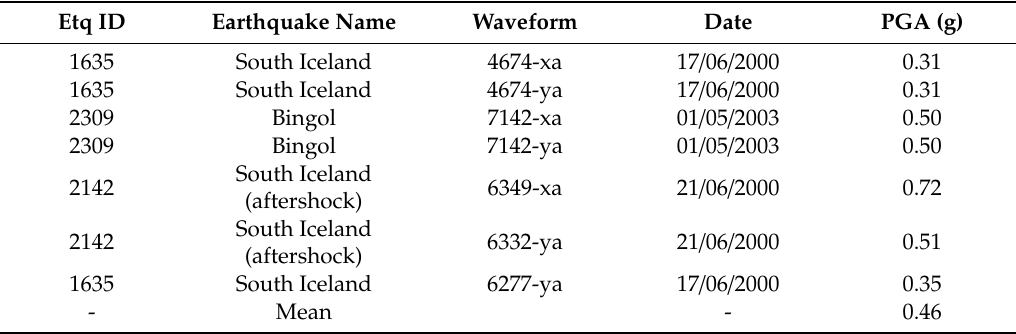
Table 2. List of the selected ground